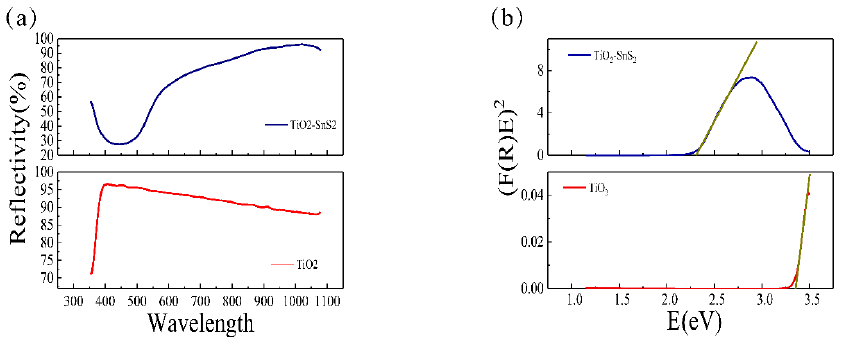
Figure 5. ( a ) The reflection spectra of TiO 2 -SnS 2 and TiO 2 nanobelts. ( b ) Plots of (F(R)E) 2 versus pho- ton energy E. photon energy